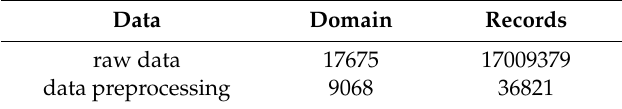
Table 3. Average size of daily